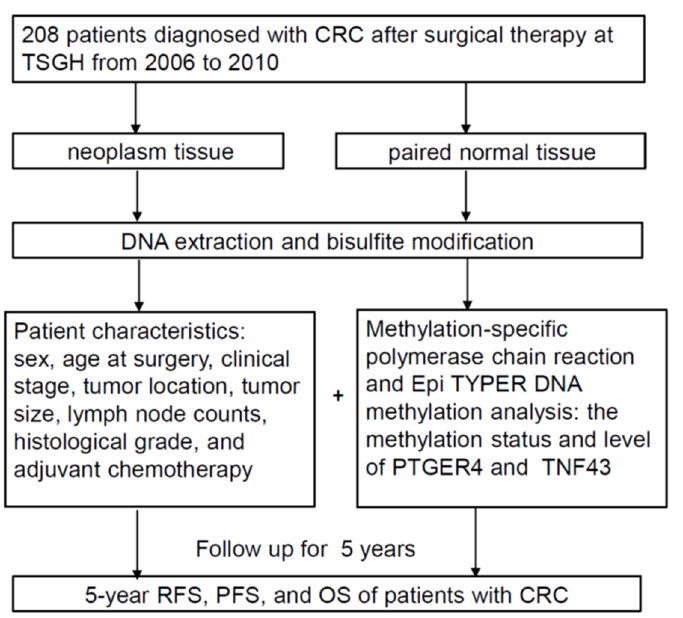
Figure 3. The study framework flow chart. CRC: colorectal cancer; TSGH: Tri-Service General Hospital; RFS: recurrence-free survival; PFS: progression-free survival; OS: overall survival.